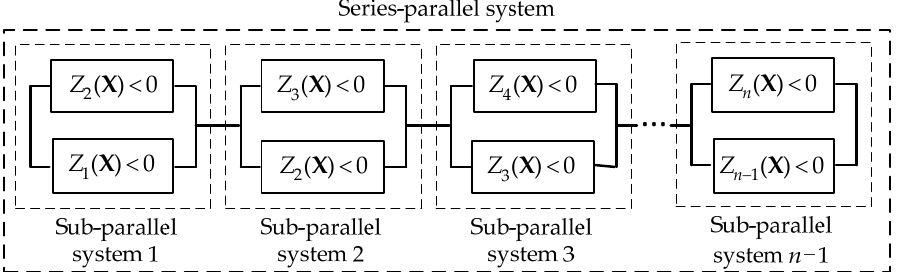
Figure 3. Series ‐ parallel system composed of multiple sub ‐ parallel systems (sub ‐ parallel system with two components).